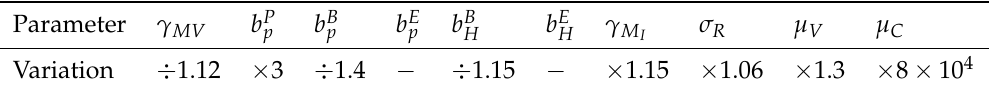
Table 2. Thresholds for individual parameter variations which lead to virus persistence. Abbrevia- tions for the parameters: γ MV —rate constant of APC stimulation; b P p —rate constant of plasma cell stimulation; b B p —rate constant of B cell stimulation; b E p —rate constant of CTL stimulation; b B constant of Th2 cells stimulation; b E —rate constant of Th1 cells stimulation; γ M H